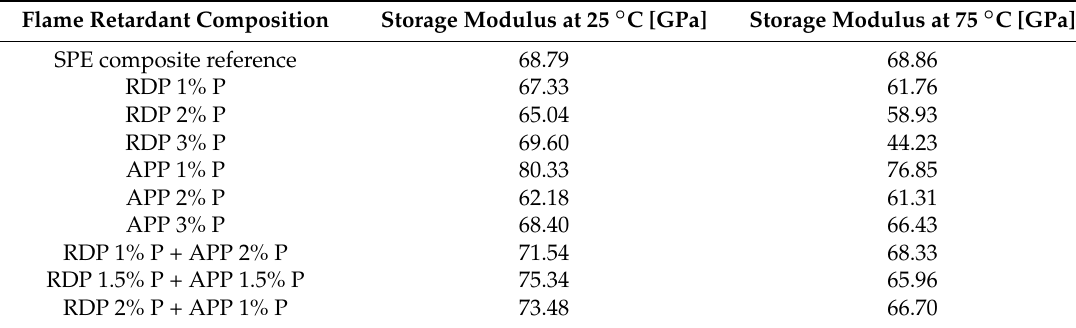
Table 5. Tensile, flexural, interlaminar shear, and Charpy impact properties of reference and flame retarded SPE composites. Flame Retardant Composition